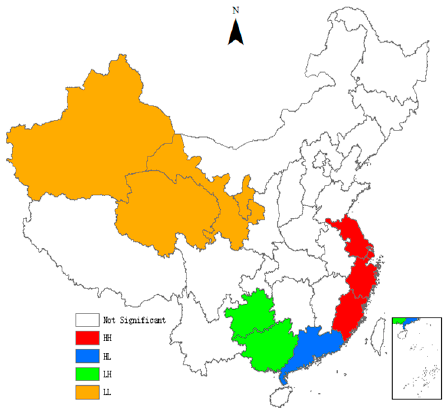
Figure 3. LISA agglomeration between 2010 and 2011.